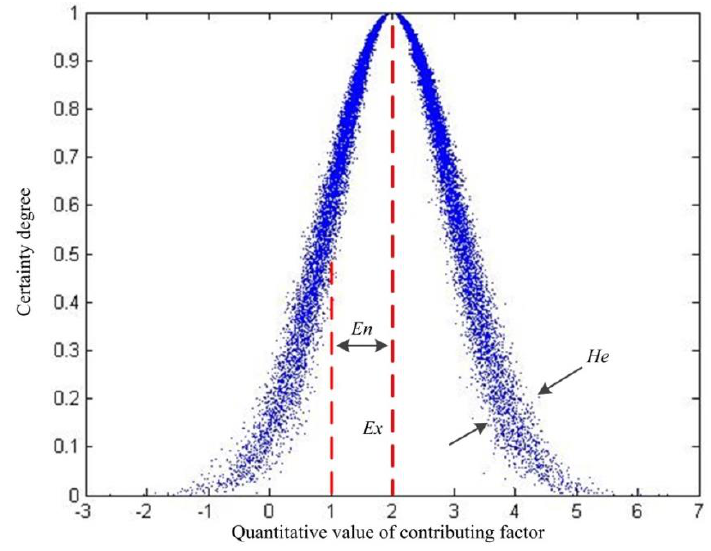
Figure 3. Normal cloud model with parameters Ex = 2, En = 1, and He = 0.1.